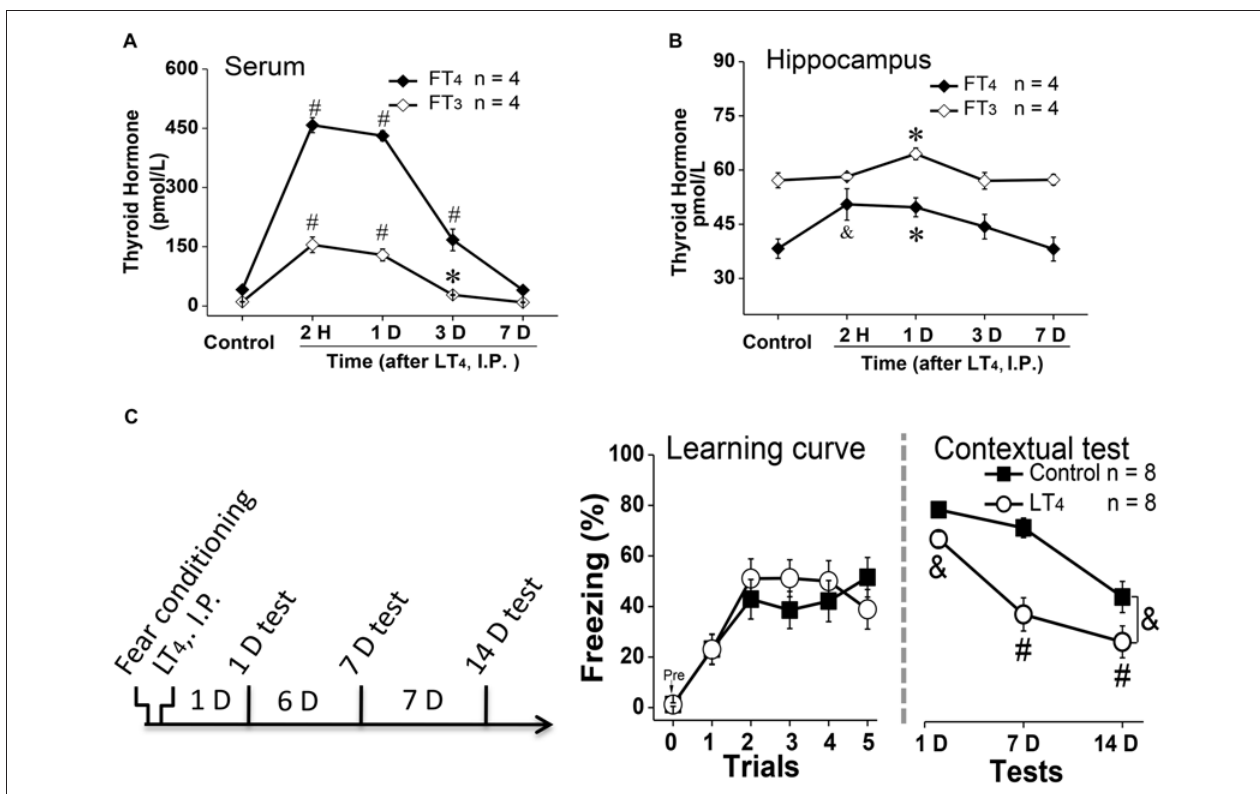
FIGURE 1 | Effects of systemic injection of LT 4 on thyroid hormones (THs) in serum and hippocampus. The time course of THs concentration after a single systemic administration of LT 4 (15 µ g/kg, I.P.) in (A) serum and (B) hippocampus. (C) Left: rats were intraperitoneally injected with LT 4 immediately after fear conditioning and carried out dependent 1-day, 7-day, 14-day memory tests; Middle: the learning curve during fear conditioning training; Right: contextual fear memory tests 1 day, 7 days and 14 days after training. LT 4 group, rats injected with LT 4 ; Control group, rats injected with saline. Numbers in bars represent animal numbers. I.P., intraperitoneal injection; H, hour; D, day; LT 4 , levothyroxine; FT 4 , free tetraiodothyronine; FT 3 , free triiodothyronine. ∗ P < 0.05, & P < 0.01, # P < 0.001.